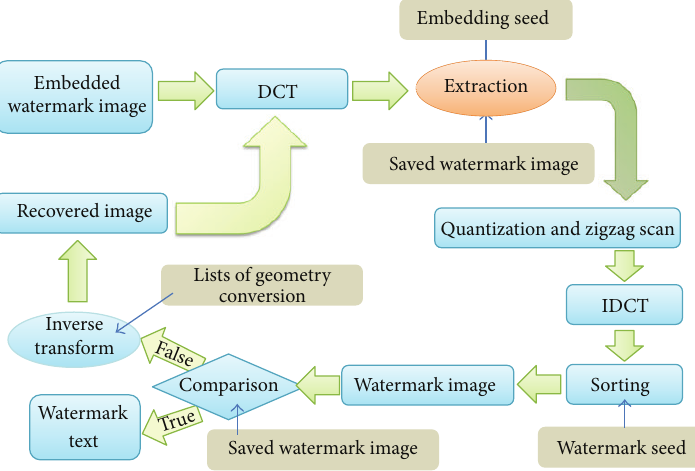
Figure 5: Extraction process of